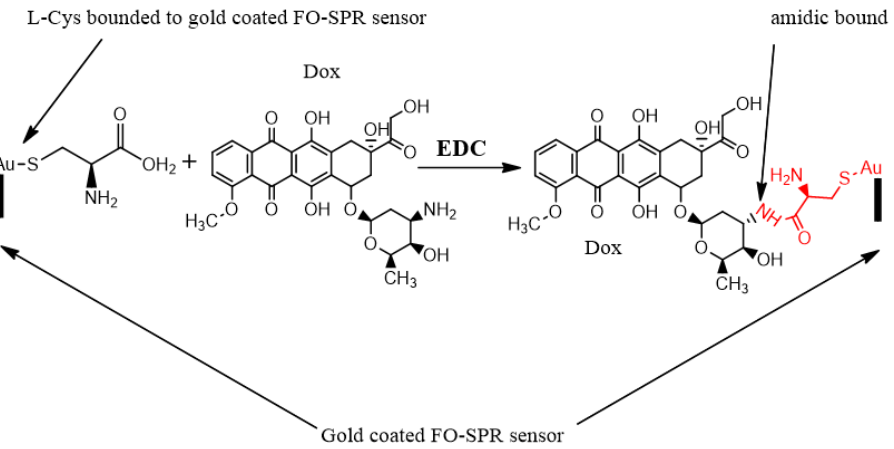
Figure 7. Schematic representation of the chemical interaction between Dox and L-Cys, monitored using the FO-SPR sensor. The L-Cys carboxylic acid is conjugated to doxorubicin amine through amide bonding using EDC (1-ethyl-3-(3-dimethylaminopropyl)carbodiimide) as coupling agent. Extended evidence supports a decrease in pH within the extracellular tumor micoenvironment as compared to physiological values [51,52]. Moreover, iron-based NPs may encounter acidic organellar pH upon intracellular uptake into cancer cells [53,54]. In order to evaluate the potential variation of NPs’ Dox release response function due to pH, Fe 3 O 4 -L-Cys-Dox NPs were incubated in two buffers with pH values of 7.4 (PBS) and 3 (citrate buffer), respectively. The samples were incubated for up to 48 h, and the release of Dox was determined using UV-Vis spectrometry after 1, 2, 24 and 48 h. Further, the amount of Dox released cumulatively from NP solutions (200 µg/mL concentration) was determined. As it can be seen from Figure 8A and B, after 1 and 24 h of incubation, the Fe 3 O 4 -L-Cys-Dox samples acquired an orange color. The spectrofluorimetric quantifica- tion indicates an enhanced release of Dox in the acidic environment for all tested inter- vals (Figure 8C). One can see that the concentration of Dox released in the first hours of incubation was of 10 – 15 µM/h (from a solution of 200 µg/mL NPs) for Fe 3 O 4 -L-Cys-Dox, which is expected to induce an increased cytotoxic effect on melanoma cells. The effect should be even more intense in the acidic tumor environment, which would allow a much lower dose of the drug-loaded NPs to be applied. Further work will be dedicated to assess the release capacity of our formulation in vivo in animal models.